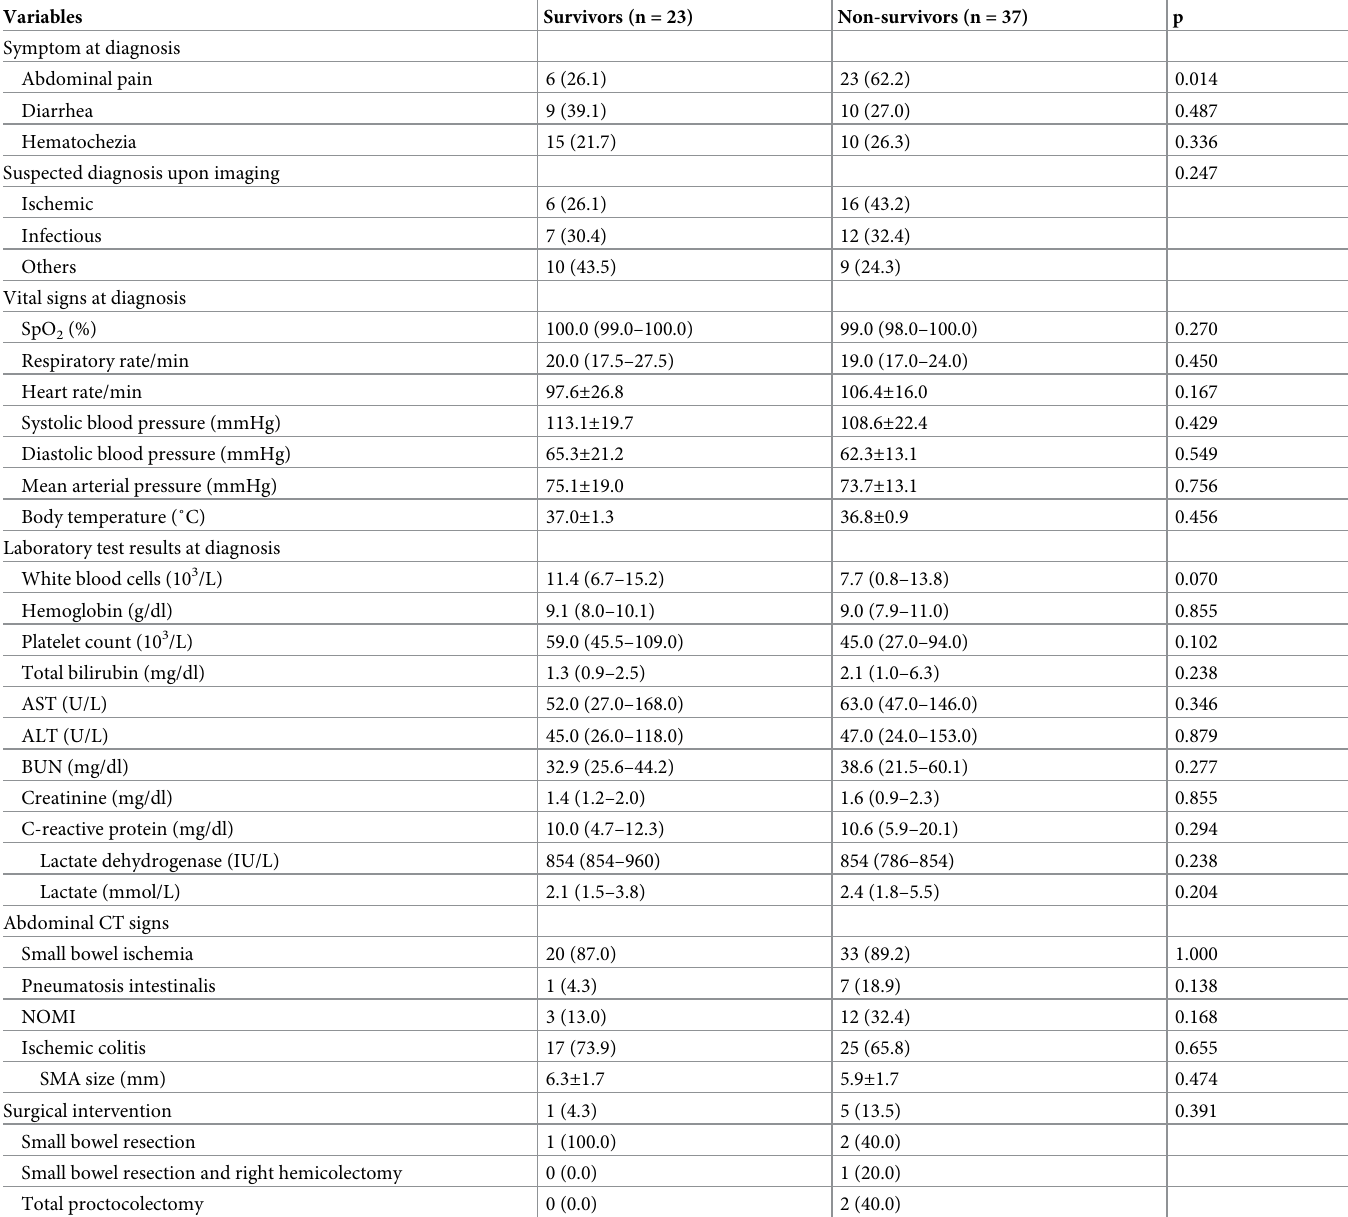
Table 2. Characteristics of the patients with